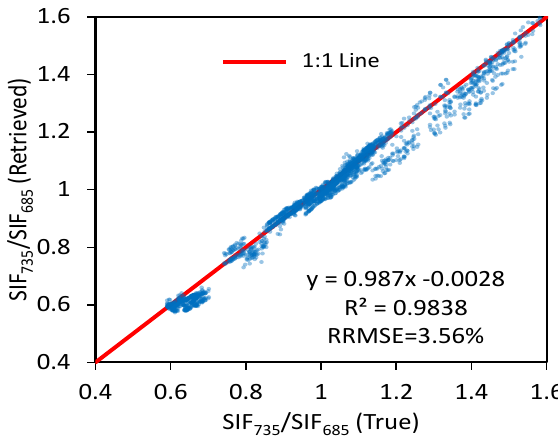
Figure 5. ( a ) An example of a retrieved reflectance spectrum (black dashed line) together with the true reflectance spectrum from the test dataset (solid gray line); ( b ) An example of a retrieved SIF spectrum (dashed black line) together with the true SIF spectrum from the test dataset (solid gray line); ( c ) The full spectral RRMSE of the 2304 retrieved SIF spectra in the test dataset (black) together with the mean SIF spectrum (gray). These results were derived from data with an SR of 0.3 nm and without noise. The dashed vertical lines show the central position of the three absorption bands.